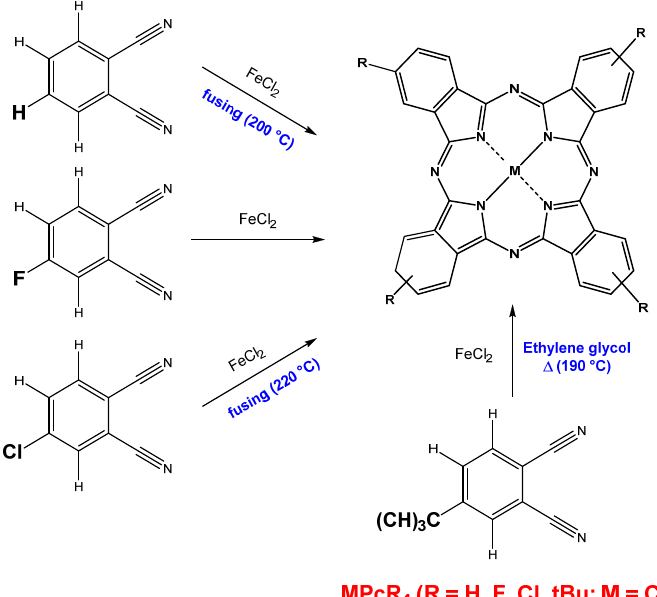
Figure 1. Synthetic route of MPcR 4 (R = H, F, Cl, tBu; M = Co, Fe).